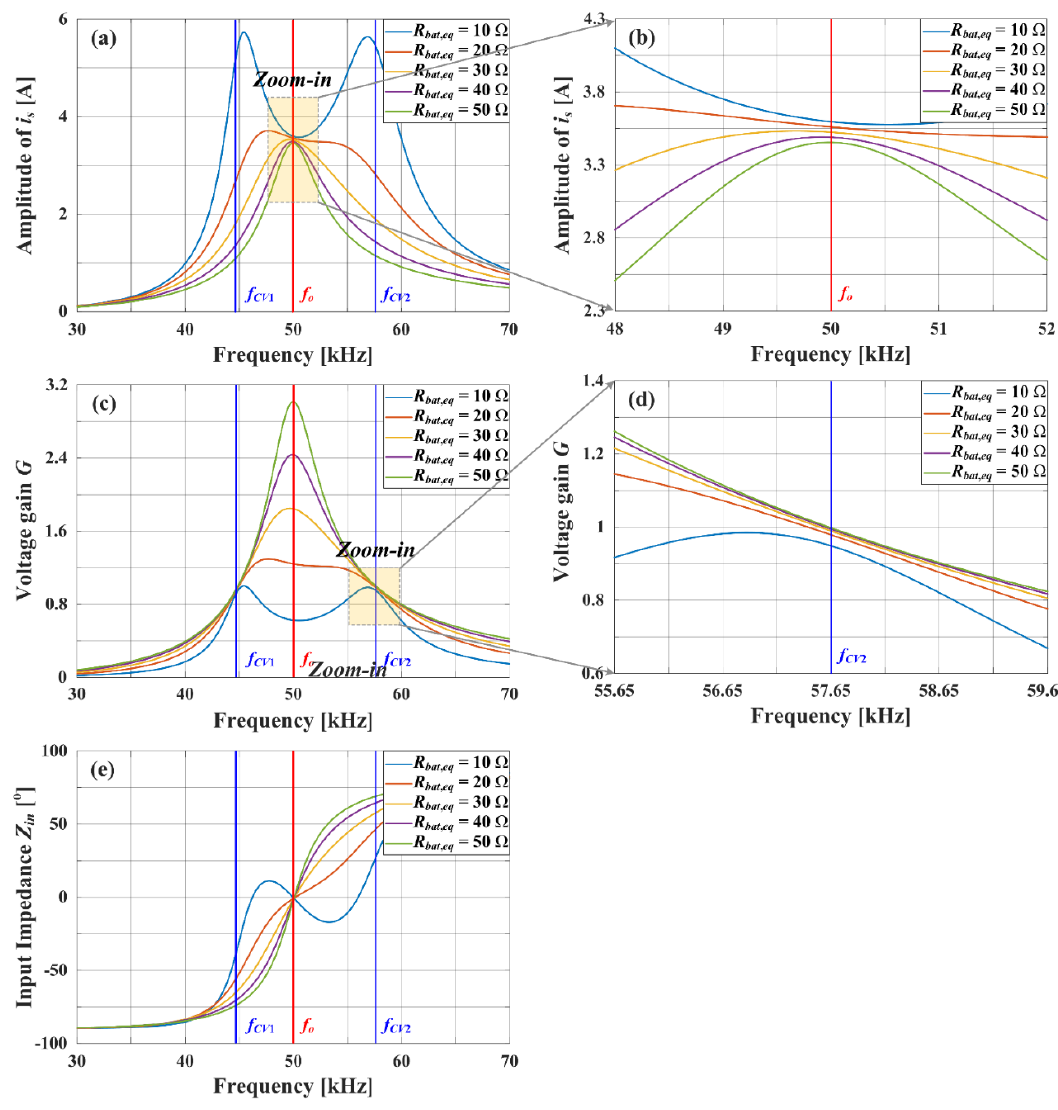
Figure 5. Electrical characteristics of single-stage wireless battery charging circuit, when V DC = 45 V, α = 0, L p = 201.89 μH, L s = 202.9 μH, C p = 50.05 nF, C s = 49.92 nF, M ps = 50. 17 μH, R in = 12 mΩ, R p = 242 mΩ and R s = 392 mΩ. ( a ) amplitude of i s ; ( b ) zoom-in waveform of I s ; ( c ) voltage gain G ; ( d ) zoom-in waveform of G ; ( e ) Phase of input impedance Z in .